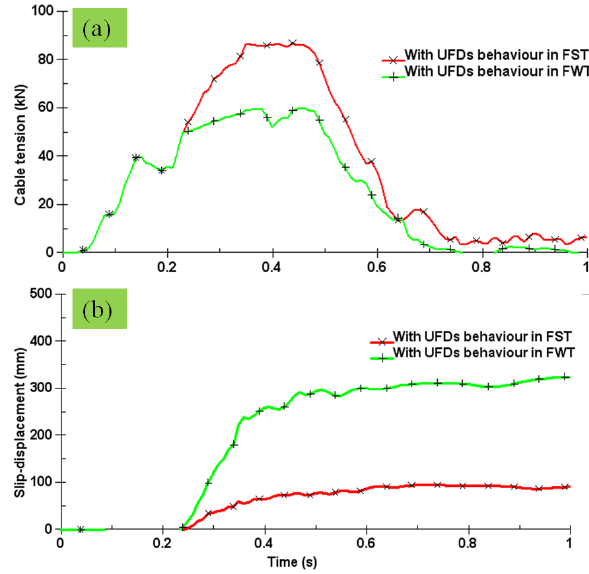
Figure 12. Numerically simulated evolution of maximum cable tension (a) and slip-2 Fig. 12. Numerically simulated evolution of maximum cable ten- displacement (b) responses of the R-LPR structure when integrated with the UFDs having 3 sion (a) and slip displacement (b) responses of the R-LPR structure their constitutive behaviour as exhibited in structure-level impact test (FST) and element-level 4 when integrated with the UFDs having their constitutive behaviour (isolated) test of the UFDs (FWT). 5 as exhibited in structure-level impact test (FST) and element-level (isolated) test of the UFDs